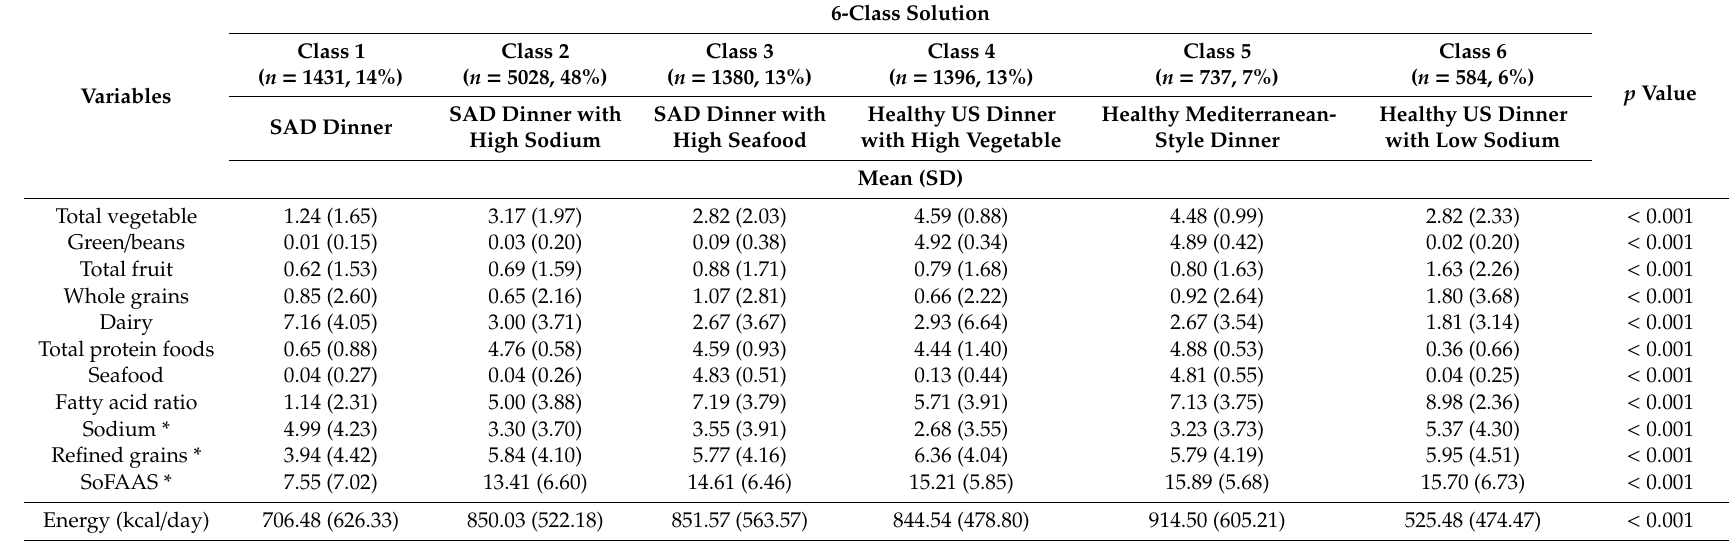
Table 6. Di ff erences in dinner HEI-2010 components and energy (kcal / day) among the latent classes of the NHANES 2007–2010 population (age ≥ 19 years, N = 10,556).